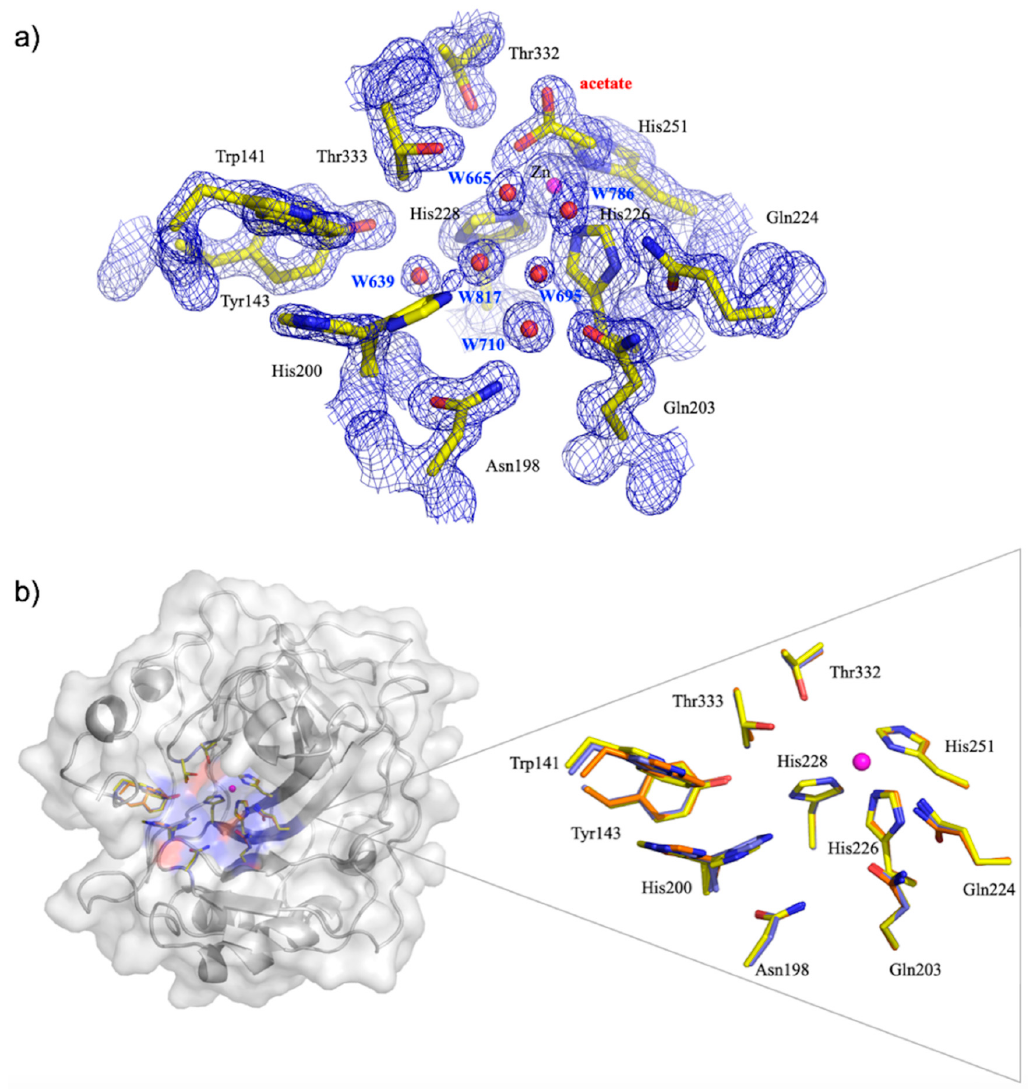
Figure 7. ( a ) Active site of CA IX in complex with acetate shown as sticks. 2F o –F c electron density map is shown in blue mesh with 1.5 σ level for the protein / solvent / ligands and 3.0 σ for the Zn. Residues, solvent, and ligands are as labeled. ( b ) Overlay of active sites of current CA IX structure (blue) with CA IX surface variant (yellow) from PDB ID 6rqn and CA IX from PDB ID 3iai (orange) [21,46].